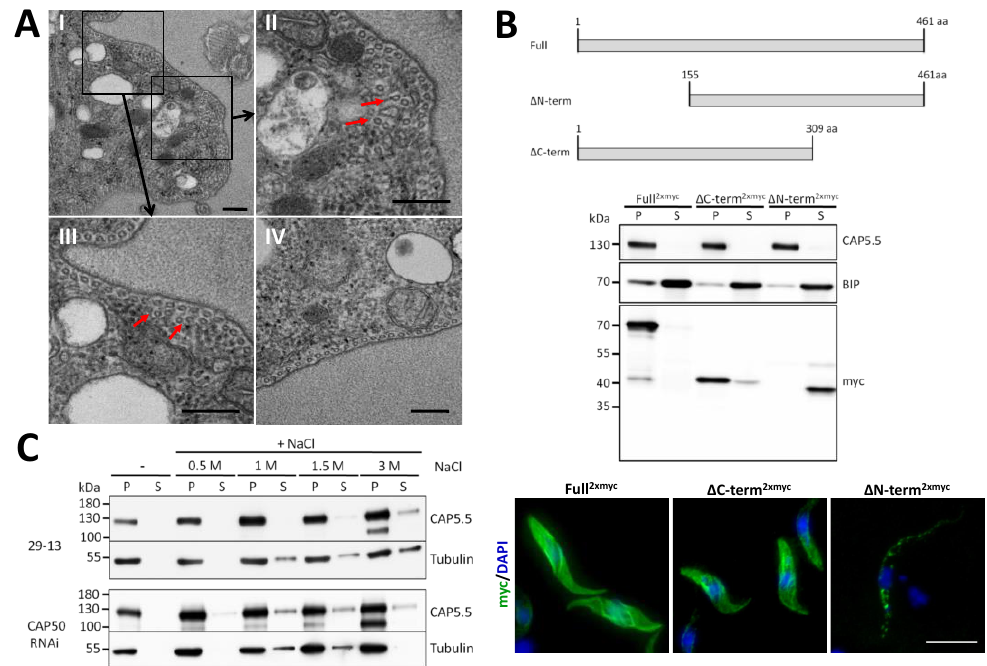
Figure 5. Ultrastructural and biochemical characterisation of CAP50. ( A ) TEM of transverse sections through procyclic cells depleted of CAP50 after RNAi induction for 3 days. Boxed areas in panel (I) are magnified in panels (II) and (III), showing examples of disordered microtubule arrays (some marked by red arrows). Panel (IV) shows a cross-section of a wild-type cell. Scale bar, 200 nm. ( B ) Truncation constructs of CAP50 used to analyse contribution of the C- or the N-terminus to cytoskeleton association of the protein. Truncation constructs and the full-length protein as control were C-terminally 2xmyc-tagged. For Western blot analysis, induced cells were fractionated with 1% NP40 in pellet (P) and supernatant (S) and the distribution of the protein was detected with an anti-myc antibody. Anti-BIP and anti-CAP5.5 were used as loading controls for the soluble and insoluble cytoskeleton fractions, respectively. For immunofluorescence cytoskeletons were labelled with an anti-myc antibody and DAPI. Scale bar, 10 µ m ( C ) Analysis of the impact of CAP50 depletion on CAP5.5 cytoskeleton association. CAP50 RNAi cells were induced for 3 days and extracted with 1% NP40. The cytoskeletal pellet fraction was subjected to increasing concentrations of NaCl and supernatant (S) and pellet (P) fractions were analysed for their CAP5.5 content by Western blotting. Anti-tubulin was used to track the integrity of the microtubules. Wild type cells (29-13) were used as a control. Equal cell number equivalents were loaded in each lane. Representative blots of three biological replicate experiments are